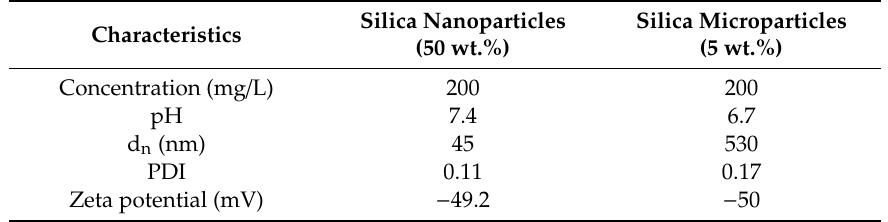
Table 1. Main characteristics of silica feed dispersions used in colloidal fouling experiments.